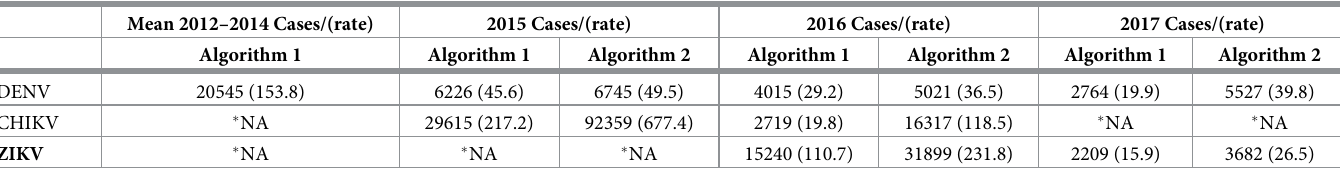
Table 4. Estimation of the number of cases and the incidence rate for infection cases caused by DENV, CHIKV and ZIKV. Mean 2012–2014 Cases/(rate) 2015 Cases/(rate) 2016